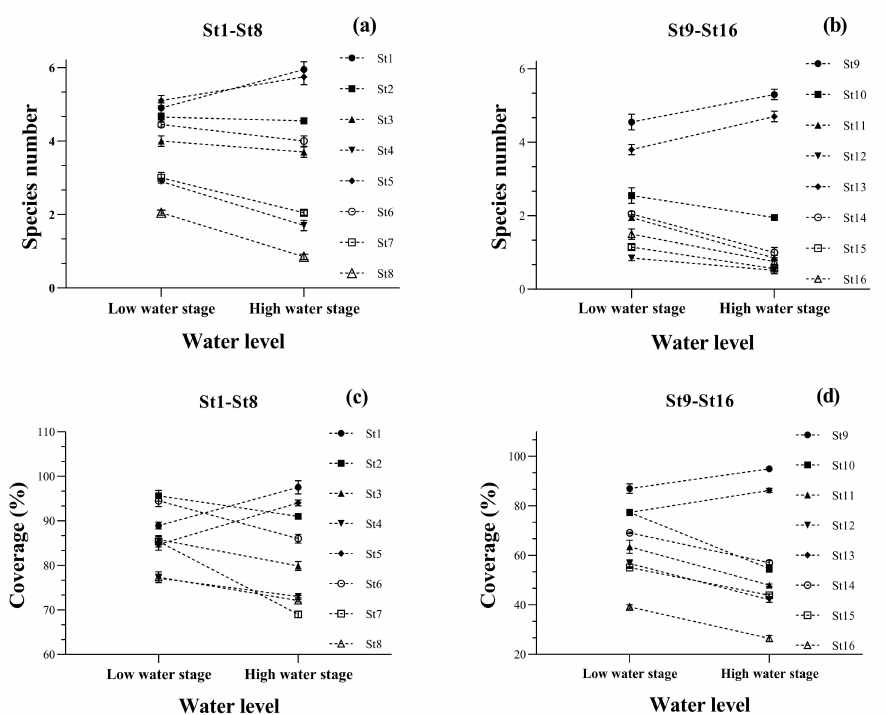
Figure 3. The species and coverage of submerged macrophytes at different water levels. ( a ) St1–St8 Species number; ( b ) St9–St16 Species number; ( c ) St1–St8 Coverage; ( d ) St9–St16